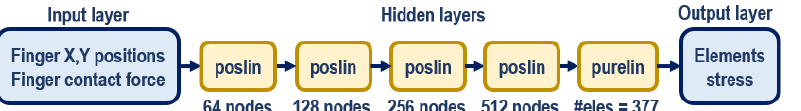
Figure 6. The ANN architecture for surrogate model training with fingers x and y positions and fingers contact force as input to the network, five hidden layers, and the maximum principal stress distribution on the elements as the output. The first four hidden layers with 64, 126, 256, and 512 nodes, respectively, implement positive linear (poslin) activation functions, and the final hidden layer which has 377 nodes corresponding to 337 elements in the ROI (#eles) uses the hard-limit linear function (purelin) for the network